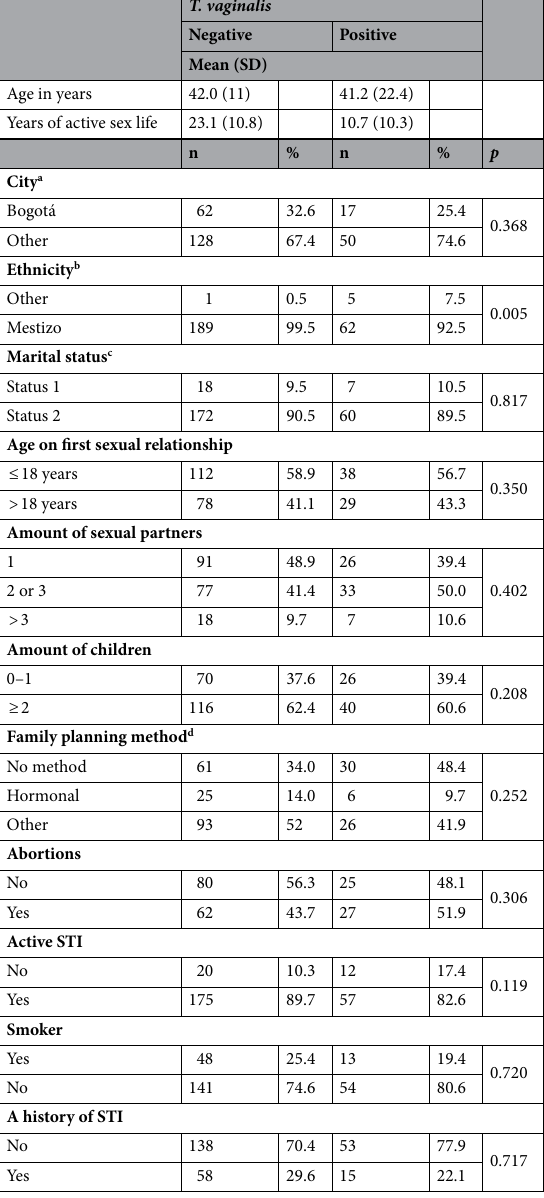
Table 1. Sociodemographic characteristics and risk factors regarding the women included (n = 264) in the retrospective component. STI sexually-transmitted infection. a City: The ‘other’ category included Girardot and Chaparral. b Ethnicity: The ‘other’ category included Afro-Colombian and indigenous people. c The ‘marital status 1’ category included single and separated women and widows; ‘marital status 2’ included married women and women living with a partner/free union. d Family planning method ‘other’ included barrier methods and